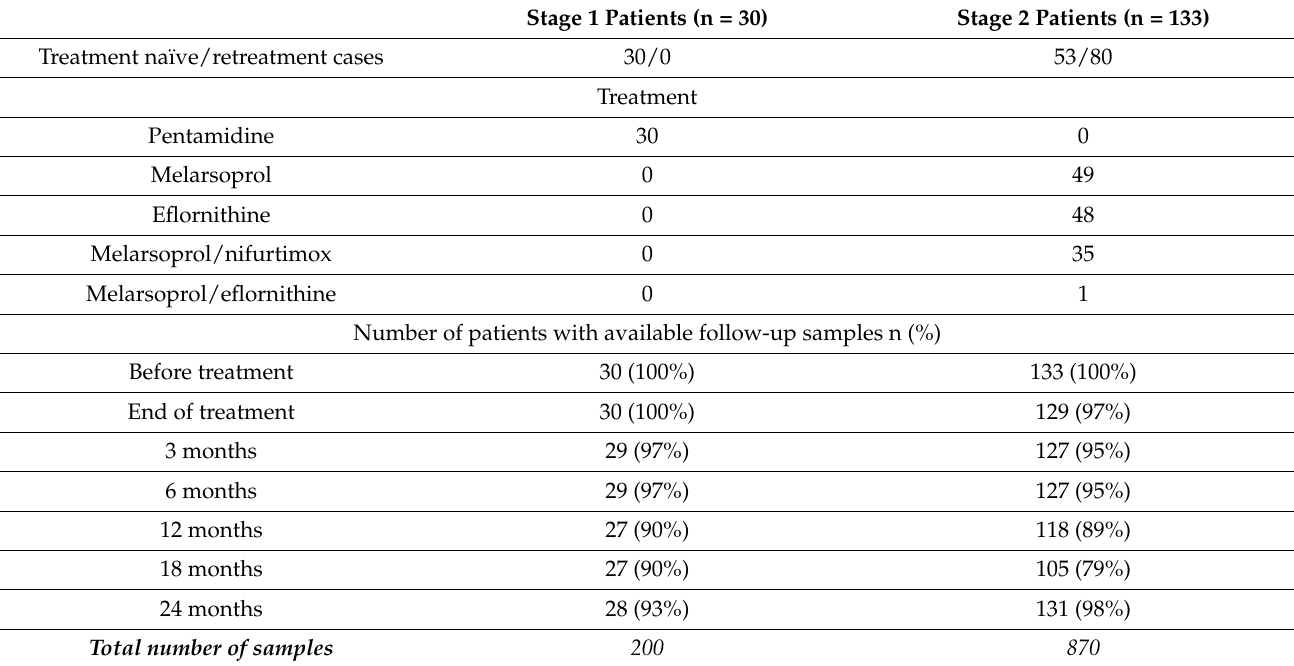
Table 1. Patient baseline characteristics and distribution of samples available for analysis (n =